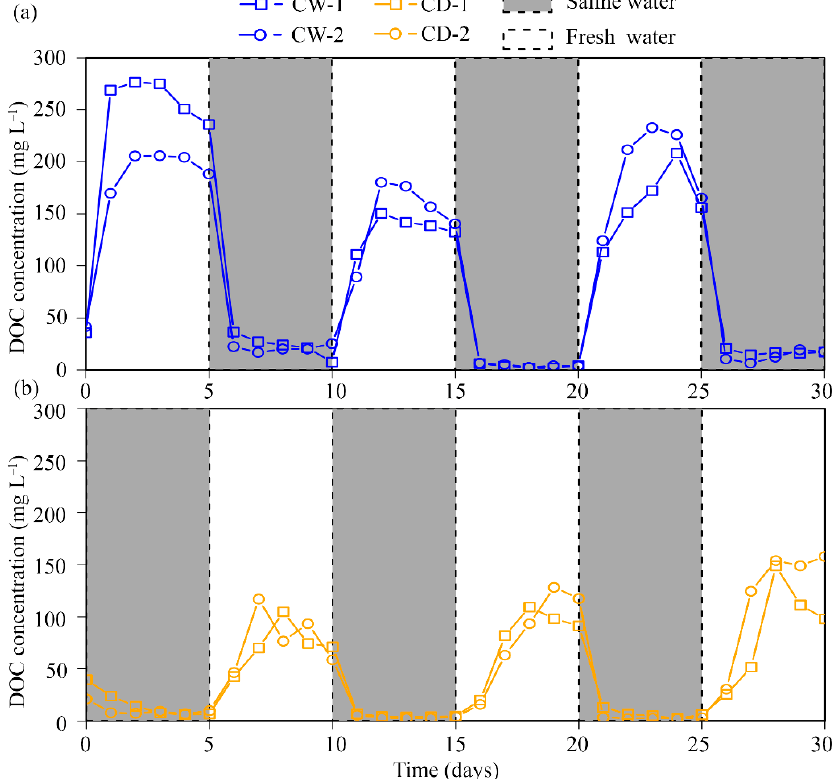
Figure 4. Dissolved organic carbon (DOC) release from peat soils under saline–fresh water cycles: ( a ) coastal rewetted, CW; and ( b ) coastal drained, CD.